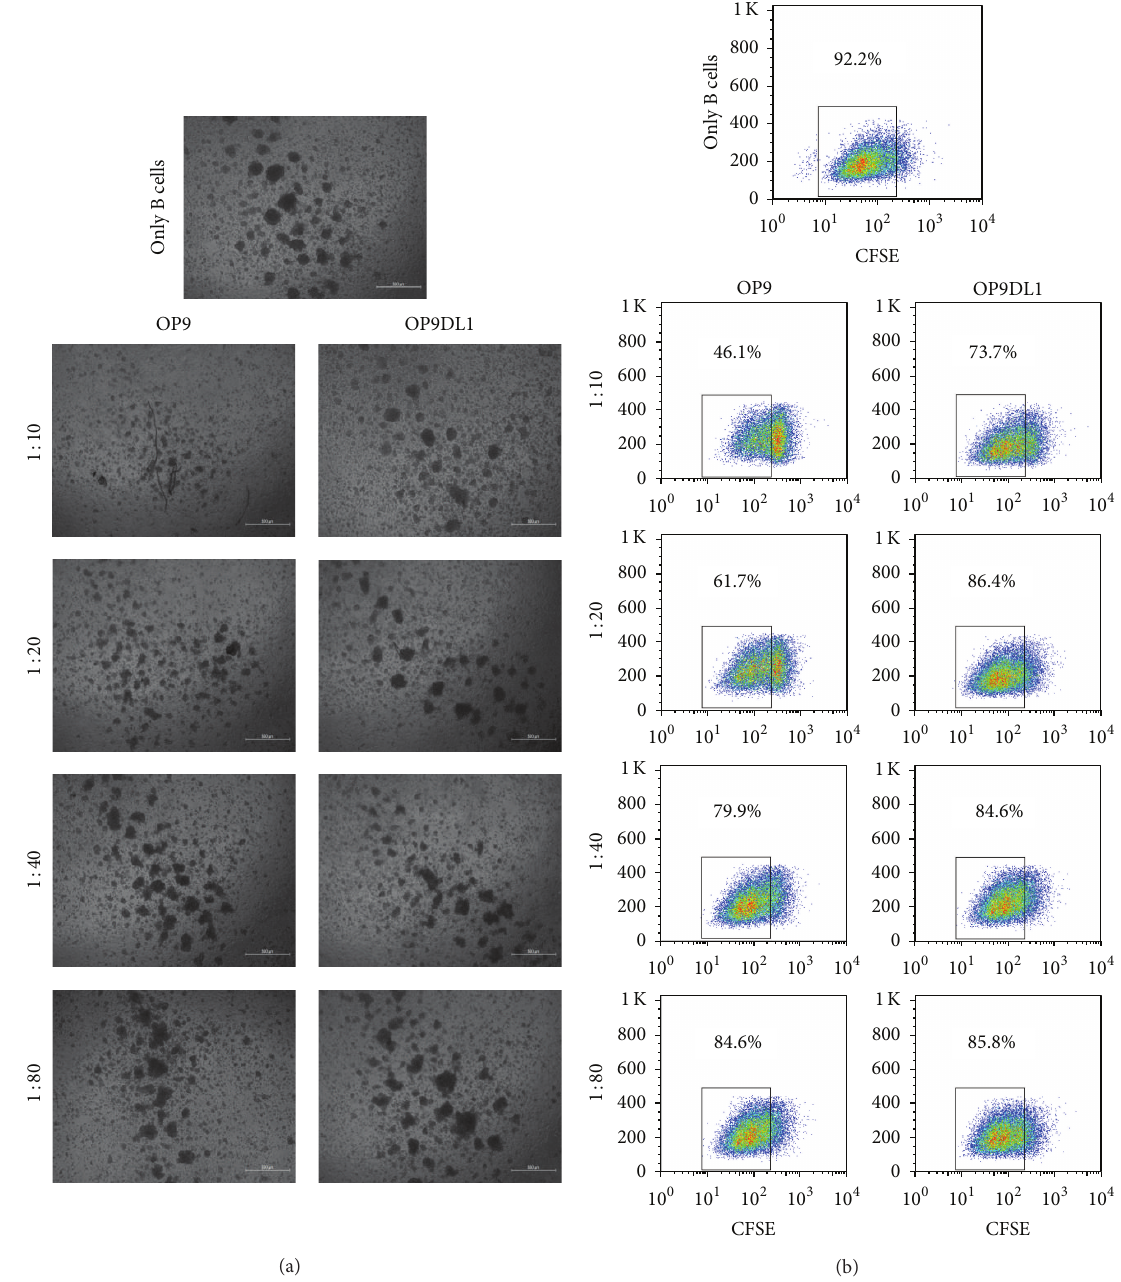
Figure 4: The effect of OP9 and OP9DL1 on proliferation of mature B cells. The B cells (B220 + ) isolated from mice spleens were stained with CFSE, then exposed with 25 ng/mL IL4 plus 10 𝜇 g/mL LPS for 24 h, and subsequently cultured alone or together with OP9 or OP9DL1 cells at different rates for 36 h. At 36 h later, the morphology of B cells in each well was observed microscopically (a), then the B cells were analyzed by FACS, and proliferation was measured by the reduction in CFSE intensity. Cell growth rates are indicated by percentages in (b). Data are representative of three